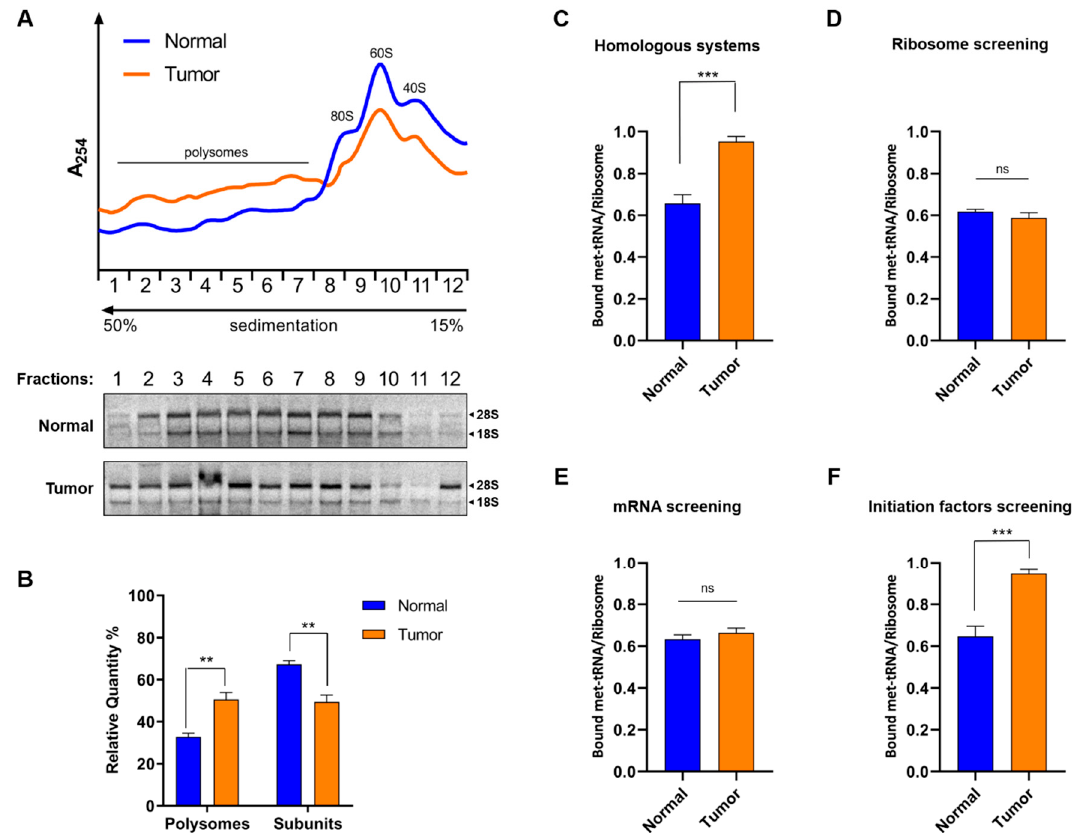
Figure 6. Determination of translational e ffi ciency in lung cancer. ( A ) Polysome profiling. Ribosomal particles isolated from either normal (blue line) or tumor (orange line) lung tissue specimens were homogenized in the presence of CHX and aliquots of the S30 fraction were analyzed on 15–50% sucrose gradients. The peaks corresponding to ribosomal subunits (40S, 60S and 80S) and the polysomes tail are indicated. ( B ) Relative quantity (%) of each peak corresponding to polysomes or free ribosomal subunits between normal (blue) and tumor (orange) specimens. ( C ) Reconstitution of 48S initiation ribosomal complex in the presence of initiator [ 3 H]Met-tRNA iMet , endogenous 40S ribosomal subunits, crude translation factors and total mRNA. All components were isolated from the same tissue specimens, either normal (blue) or tumor (orange). ( D ) Assay of 40S ribosomal subunits from normal (blue) or tumor (orange) specimens, in the presence of translation factors, mRNA and initiator [ 3 H]Met-tRNA i Met from normal tissue specimens. ( E ) Assay of mRNA from normal (blue) or tumor (orange) specimens in the presence of crude translation factors, 40S ribosomal subunits and initiator [ 3 H]Met-tRNA i Met from normal tissues. ( F ) Assay of crude translation initiation factors from normal (blue) or tumor (orange) specimens in the presence of 40S ribosomal subunits, mRNA and initiator [ 3 H]Met-tRNA iMet from normal tissues. All components tested, were isolated from the same specimen and experiments were performed in triplicates. Asterisks represent p -values after unpaired t test accomplishment between normal and tumor specimens (** p < 0.01; *** p < 0.001; ns, not significant).